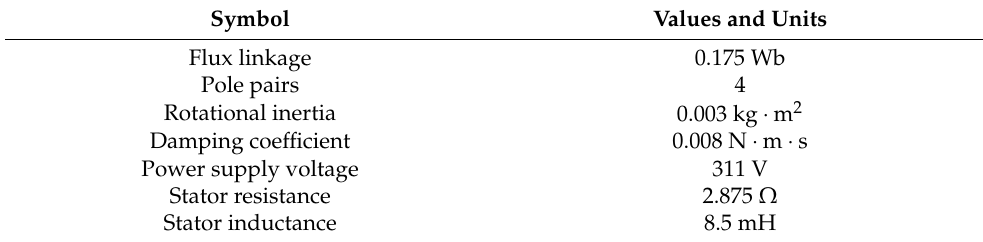
Table 1. The key PMSM parameters.